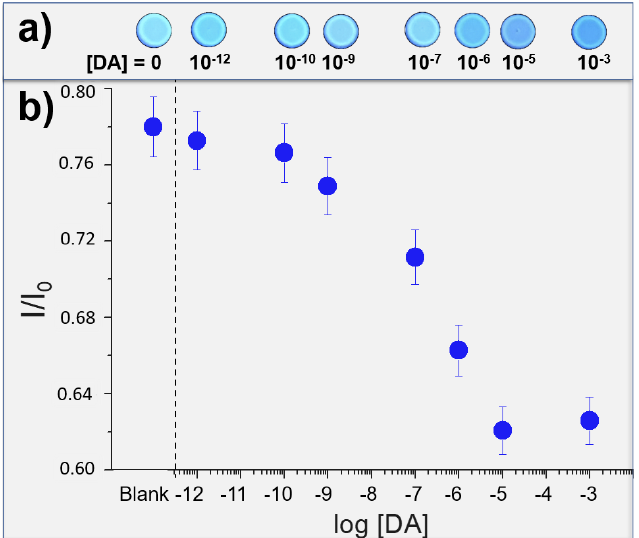
Figure 3. ( a ) photos of test strips exposed to increased amounts of DA; ( b ) correlation between the log[DA] and the normalized emission values of the solid sensor (I/I 0 , where I and I 0 are the Gray channel emission values of Cav-4-Qx and control probe, respectively).